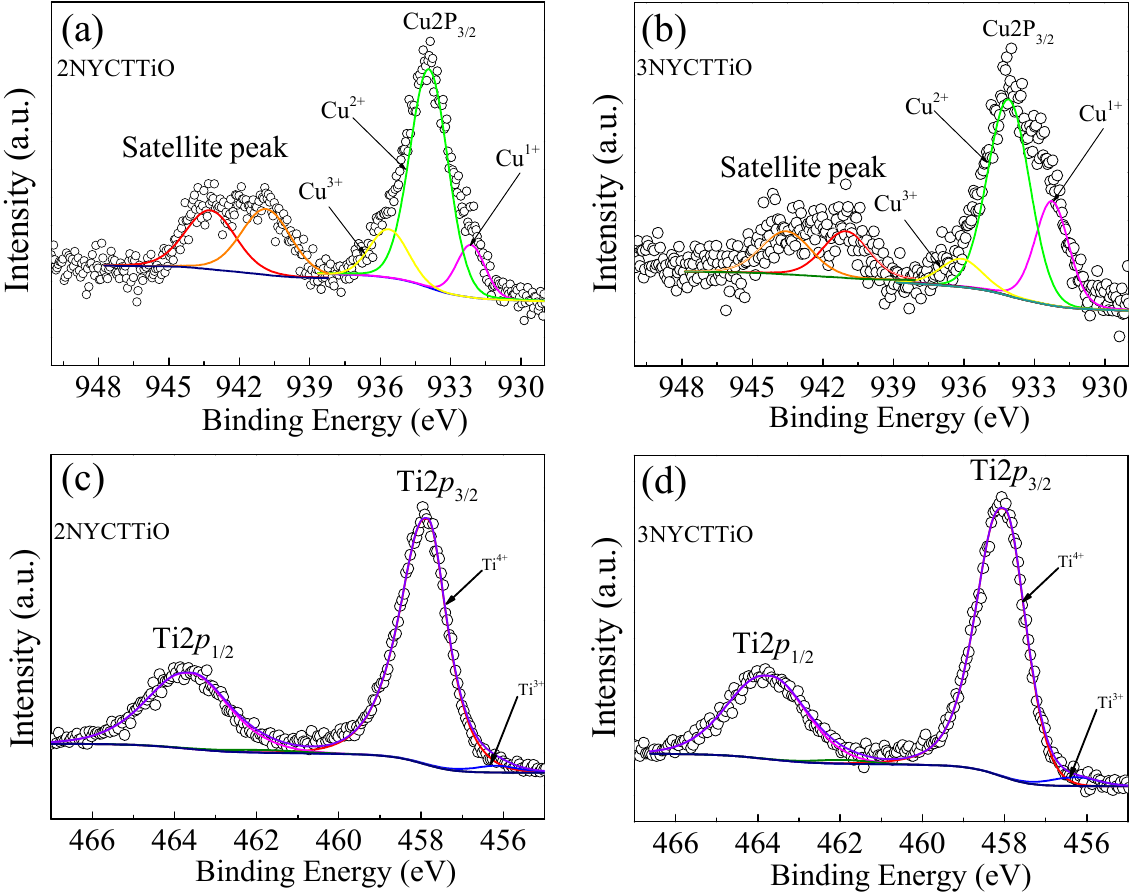
Figure 8. ( a , b ) XPS spectra of Cu2p and ( c , d ) XPS spectra of Ti2p 3/2 for Na 1/2 Y 1/2 Cu 3 Ti 4.1 O 12 ceramics sintered at 1070 °C for 5 and 15 h.